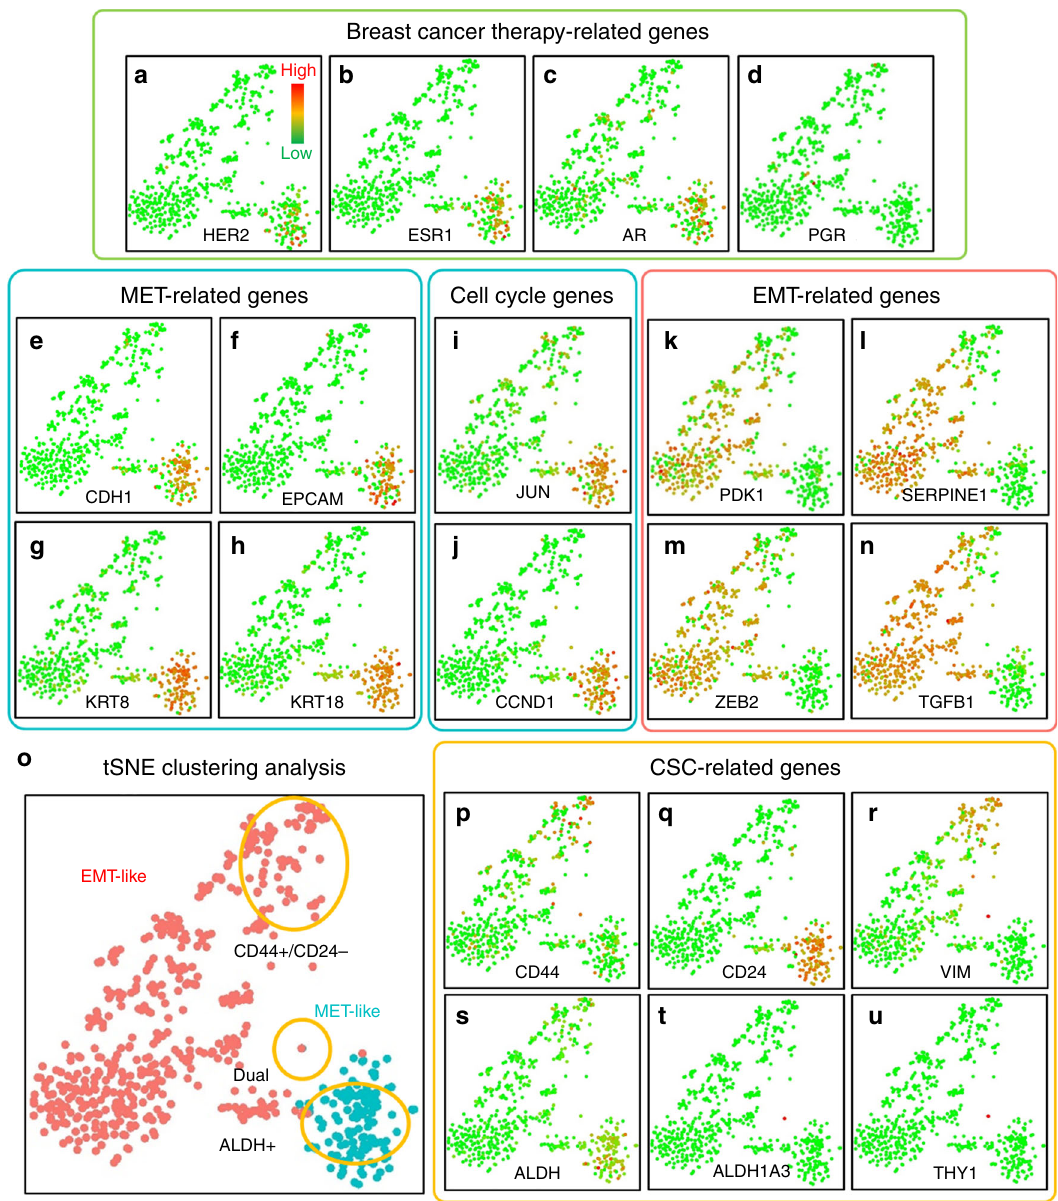
Fig. 4 Gene expression and clustering of breast CTCs. a – d Breast cancer therapy related genes: a human epidermal growth factor receptor 2 (HER2/ Erbb2), b estrogen receptor (ESR1), c Androgen (AR), and d progesterone receptor (PGR). e – h MET-related genes: e E-cadherin (CDH1), f Epithelial Cell Adhesion Molecule (EPCAM), g Keratin-8 (KRT8), and h Keratin-18 (KRT18). i , j Cell cycle genes: i c-jun (JUN), and j cyclin D1 (CCND1). k – n EMT-related genes: k Phosphoinositide-dependent kinase-1 (PDK1), l Plasminogen activator inhibitor-1 (SERPINE1), m EMT transcription factor (ZEB2), and n transforming growth factor β (TGFB1). o The clustering and separation of HER2 + MET-like and HER2- EMT-like CTCs. p – u Stemness related genes: p CD44, q CD24, r vimentin (VIM), s pan-ALDH isoforms (ALDH), t ALDH1a3, and u CD90 (THY1). (Each dot represents one CTC. Green color represents the lowest expression, and red color represents the highest expression. The expression is logarithmically normalized. 666 CTCs from 21 patient samples were plotted based on tSNE clustering method.) Source data are provided as a Source Data fi